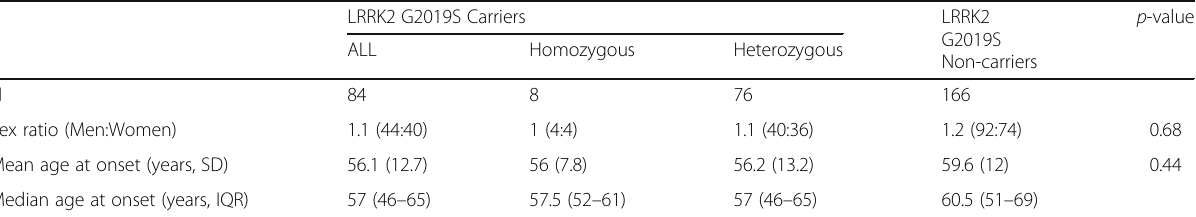
Table 2 Demographics of PD patients with and without LRRK2 G2019S mutations